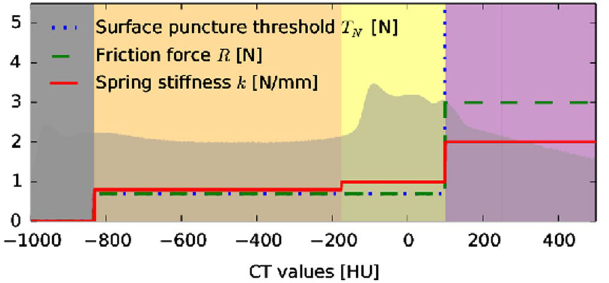
Figure 10. Haptic transfer function intervals over the histogram of the reference patient: color coded transfer function intervals of air (gray), skin (orange), soft-tissue (yellow) and bone